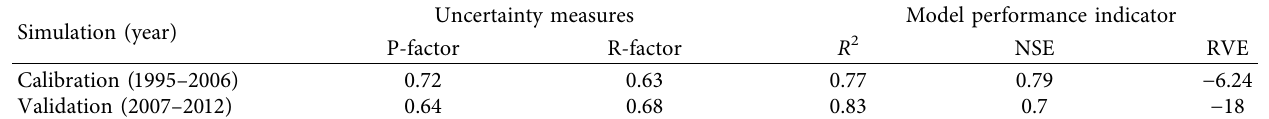
Table 2: Performance results of the model during calibration and validation of sediment simulation.